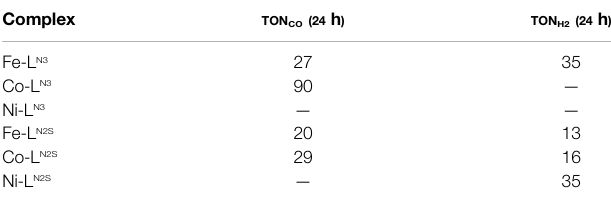
TABLE 3 | Turn over number (TON) for CO and H 2 formation for the respective complexesafter24 hofillumination.Thecatalyticreactionwasperformedwith a catalyst concentration of 5 × 10 -5 M in DMF with 5% TEA as sacri fi cial electron donor applying a λ > 400 nm longpass fi lter and a 200 W Xe-lamp ( — no product determined by